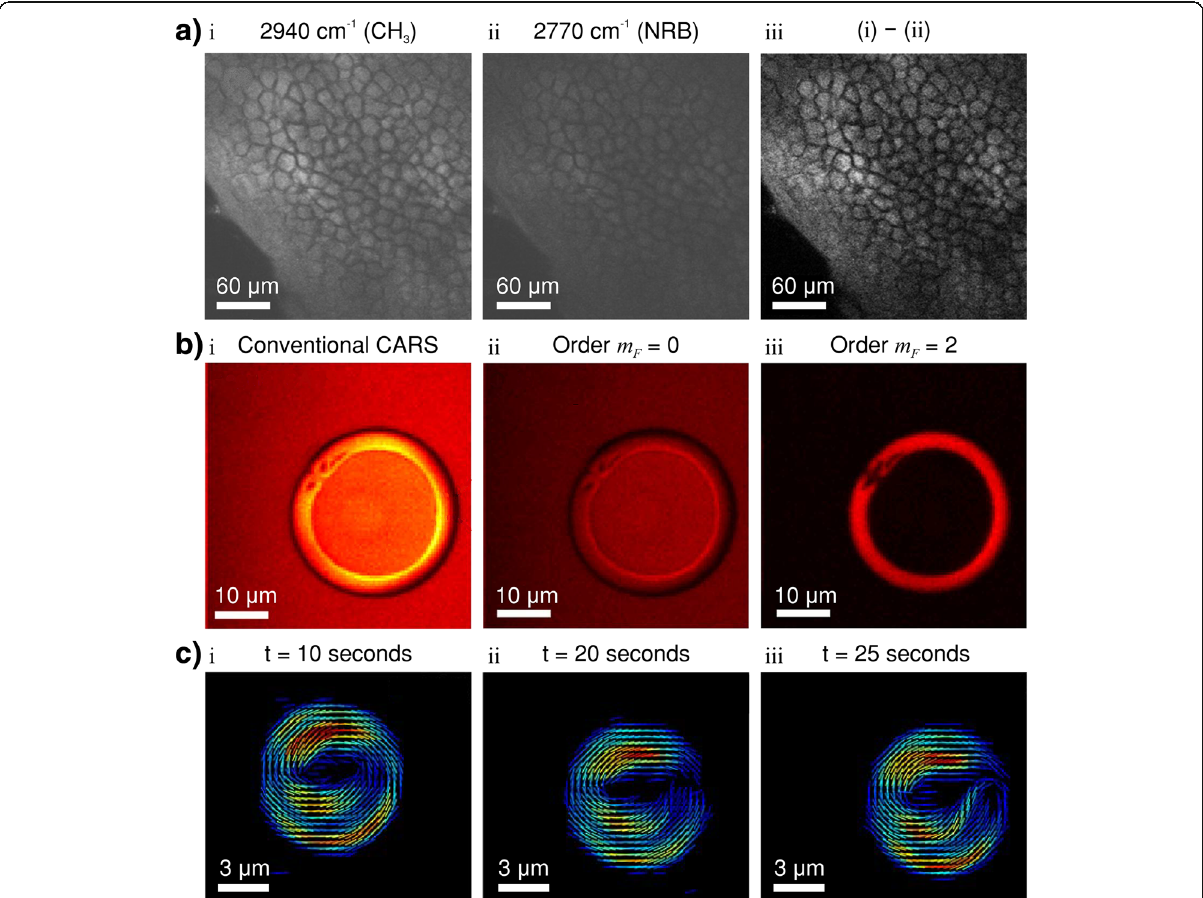
Fig. 7 a Simultaneous two-colour CARS imaging with real-time nonresonant background subtraction from a mouse tissue sample at a surface depth of 45 μ m. a i CARS image acquired at 2940 cm − 1 (CH3 stretching vibration). a ii Off-resonance background CARS image at 2770 cm − 1 . a iii Background-free image of (i) at 2940 cm-1 after subtraction of the nonresonant background (ii). b Multi-lamellar lipid vesicle (MLV) imaged with conventional (i) and symmetry-resolved CARS (SR-CARS) at 1133 cm-1 (ii) and (iii). ii The incident circularly polarised pump, Stokes, probe and anti- Stokes light have co-rotating handedness ( m F = 0). iii the incident circularly polarised pump, probe and anti-Stokes light have co-rotating handedness and the Stokes light has counter rotating handedness ( m F = 2). c High-speed polarisation-resolved CARS image sequence on a MLV moving over the sample surface taken at different times of the observation sequence shown as a composite image of S 2 and φ 2 as coloured sticks and with the acousto-optic modulation (AOM) as a grey background. a reproduced with permission from the OSA [278]. b Adapted from [289] and licenced under CC BY 4.0. c reproduced with permission from the OSA